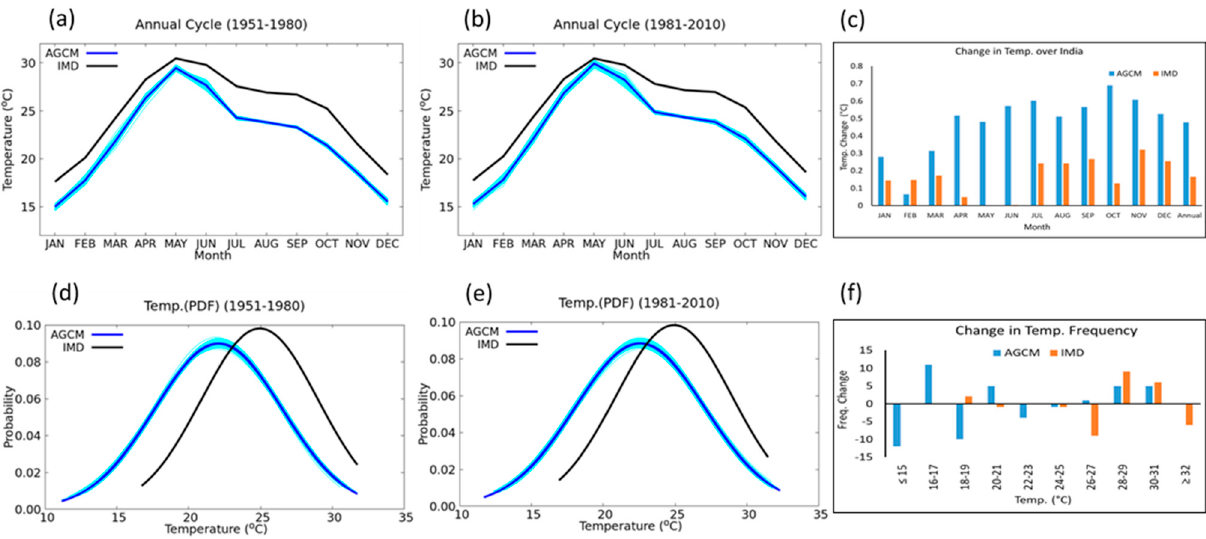
Figure 11. ( a , b ) Annual cycle, and ( d , e ) PDFs of temperature. Change in ( c ) temperature and ( f ) frequency in two climate periods. Thin lines in ( a , d ) correspond to the results for each individual member.